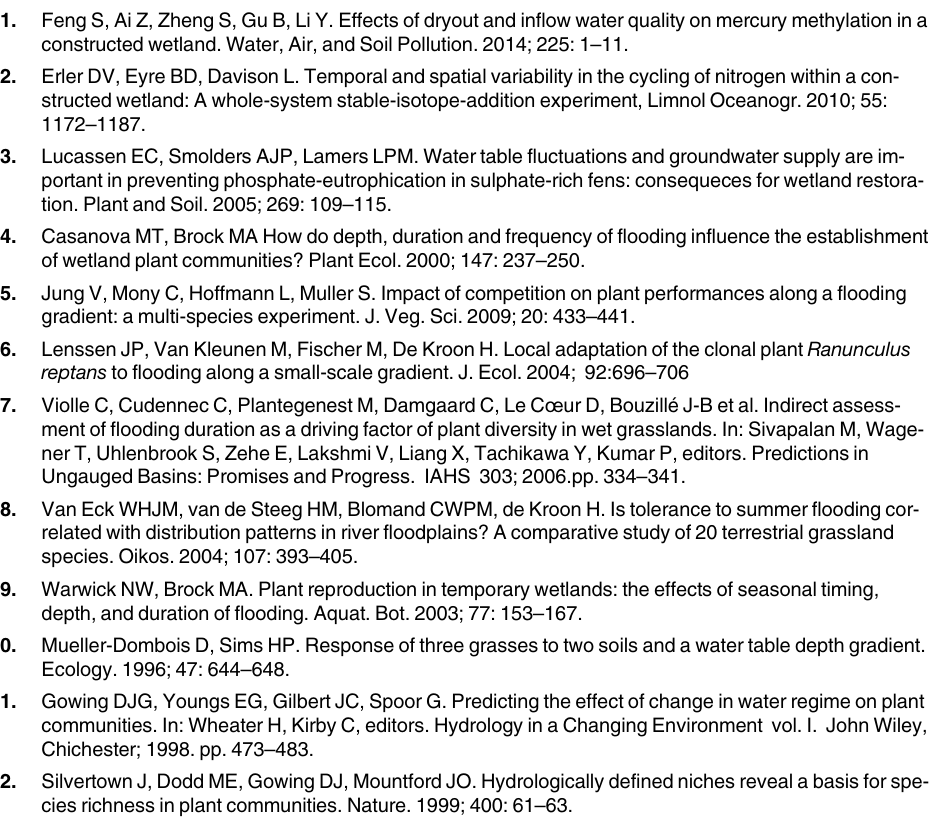
) and species com- 1 is greater 1